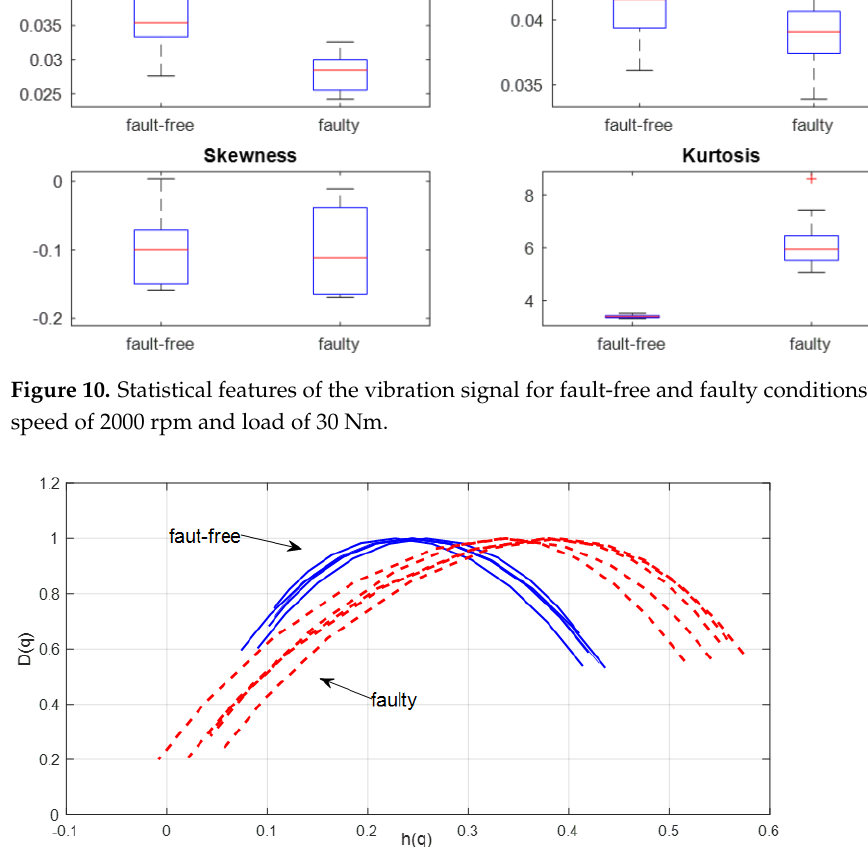
Figure 11. Multifractal spectra for fault-free (blue line) and faulty conditions (red dashed line).